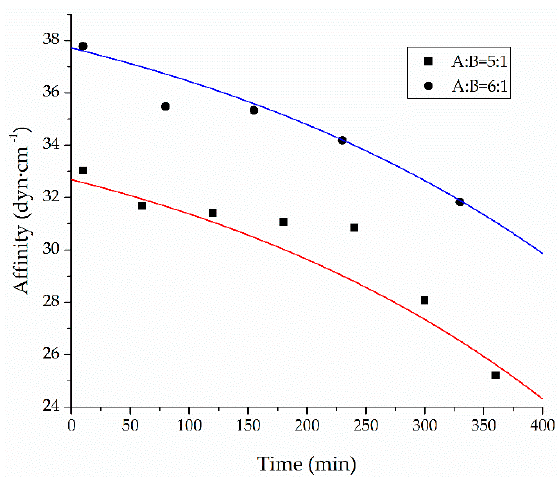
Figure 11. The comparison of the experimental data and the model curve of the slurry affinity time.